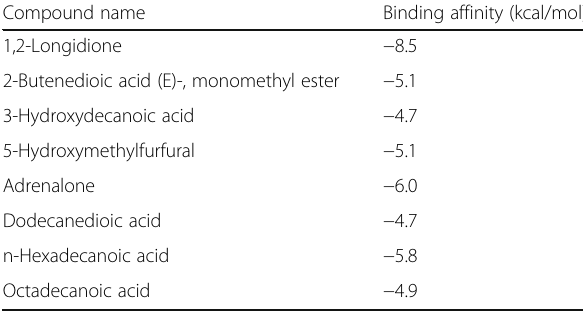
Table 3 Molecular docking results showing compounds